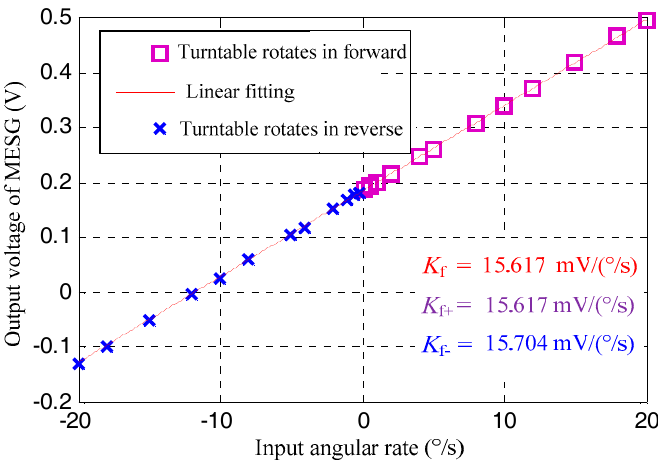
Figure 4. Scale factor test results.